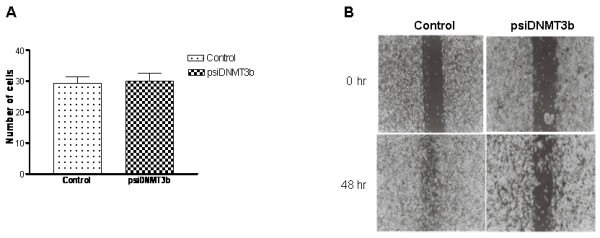
Cellular invasion and migration assays. A. Boyden chamber invasion assays were carried out on control and DNMT3b silenced cells and the number of cells invading matrigel was determined. B. Wound healing migration assays were carried out as described. Panels show wounds in control, and DNMT3b depleted cells at 0 and 48 hours.